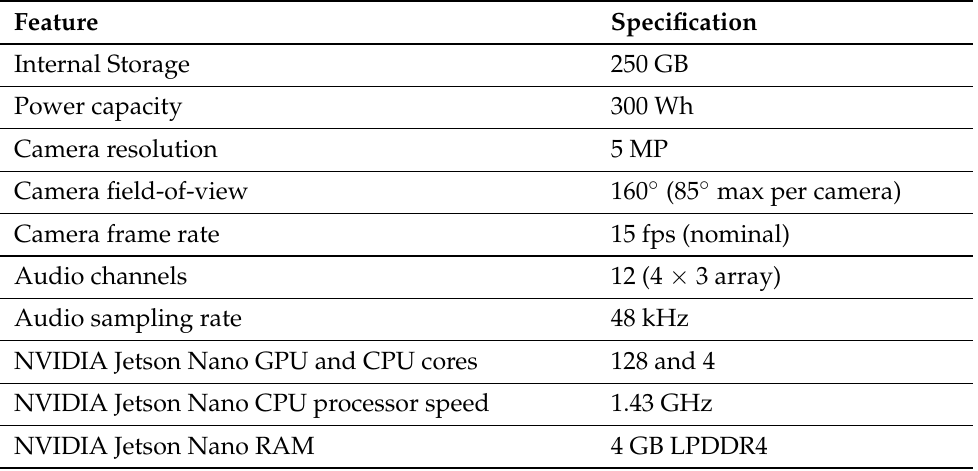
Table 2. REIP sensor specifications including its two cameras, 12-channel microphone array, and NVIDIA Jetson Nano as a computing